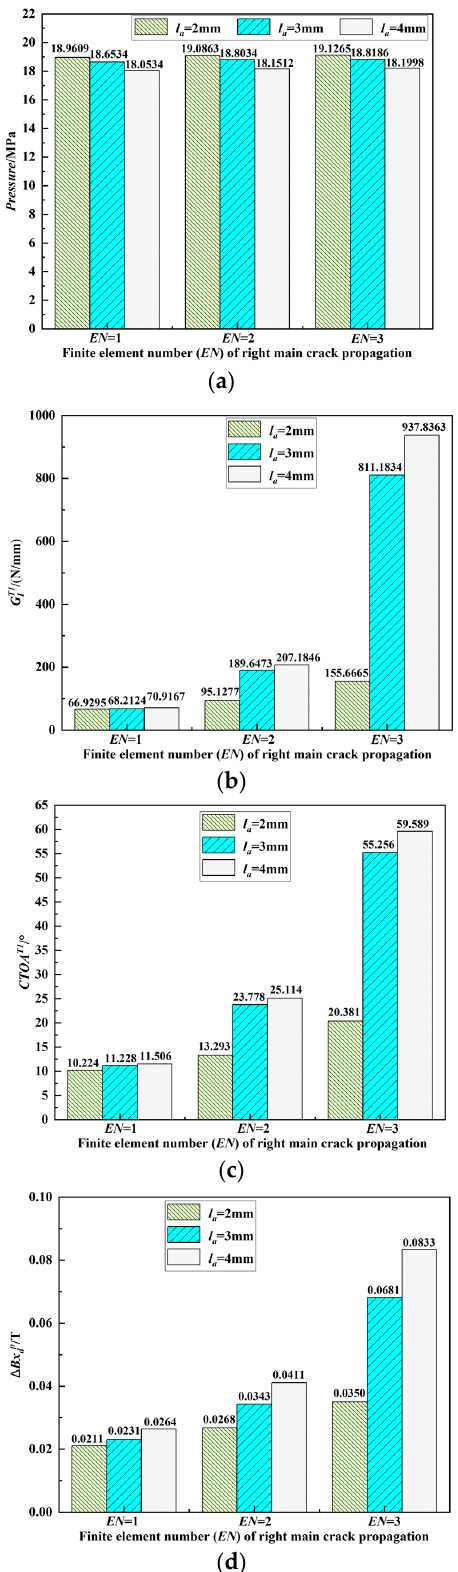
Figure 12. Influence of the auxiliary crack size on the main crack propagation. ( a ) EN = 1, 2, 3, P - l a , ( b ) EN = 1, 2, 3, G IT 1 - l a , ( c ) EN = 1, 2, 3, CTOA T 1 - l a , ( d ) EN = 1, 2, 3, ∆𝐵𝑥 (cid:3031)(cid:3043) - l a .